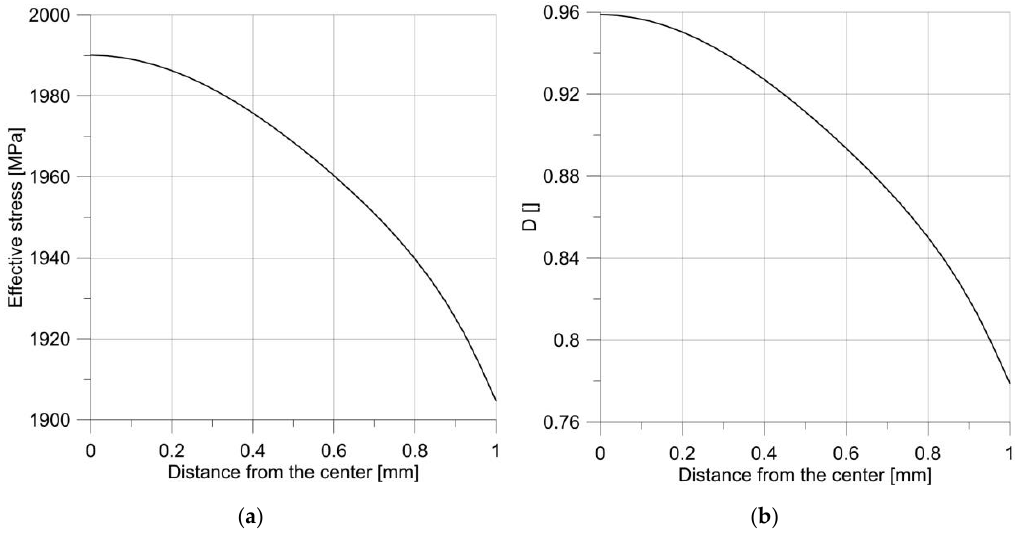
Figure 9. Distribution of effective stress ( a ) and parameter D ( b ) just before the fracture initiation of the smooth round specimen.